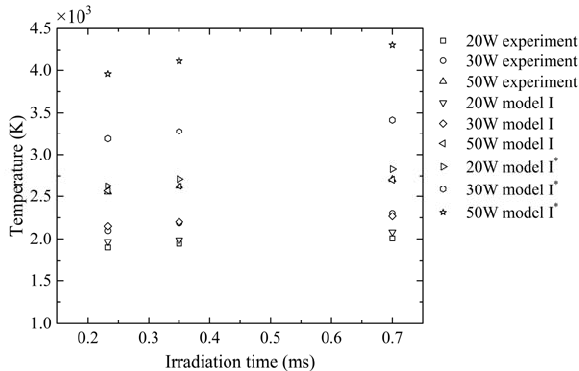
Figure 5. Comparison of the peak temperature in the simulation and in the experiment. Irradiation time is the ratio of laser spot diameter to scanning velocity. Table 3. Parameters in the experiment of Yadroitsev et al. [43].